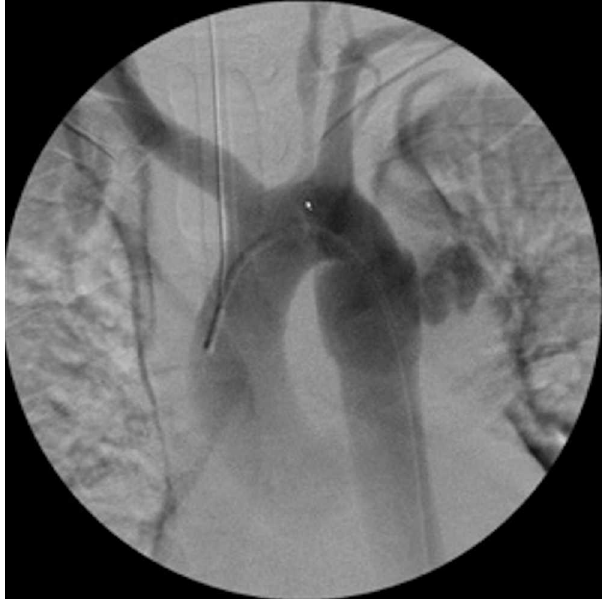
Figure 1 - Aortic rupture grade IV – active